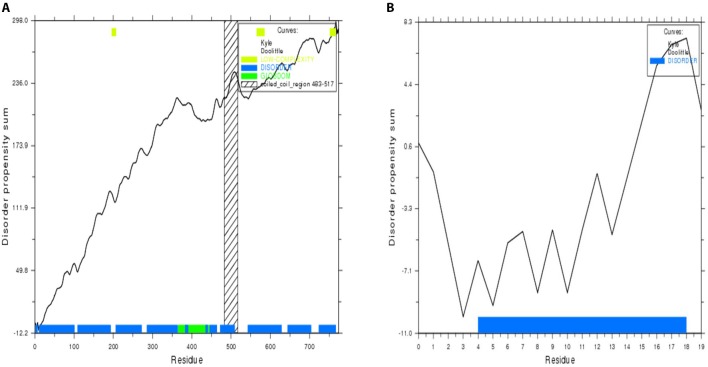
Protein disorder regions of VP4 protein including the most antigenic conserved region. (A) The disorder regions of the whole protein sequence. (B) The disorder region in the conserved region “SAIIDFKTLKNLNDNYGI.” Here, blue color indicates the disorder region while green color indicates the globular domain.